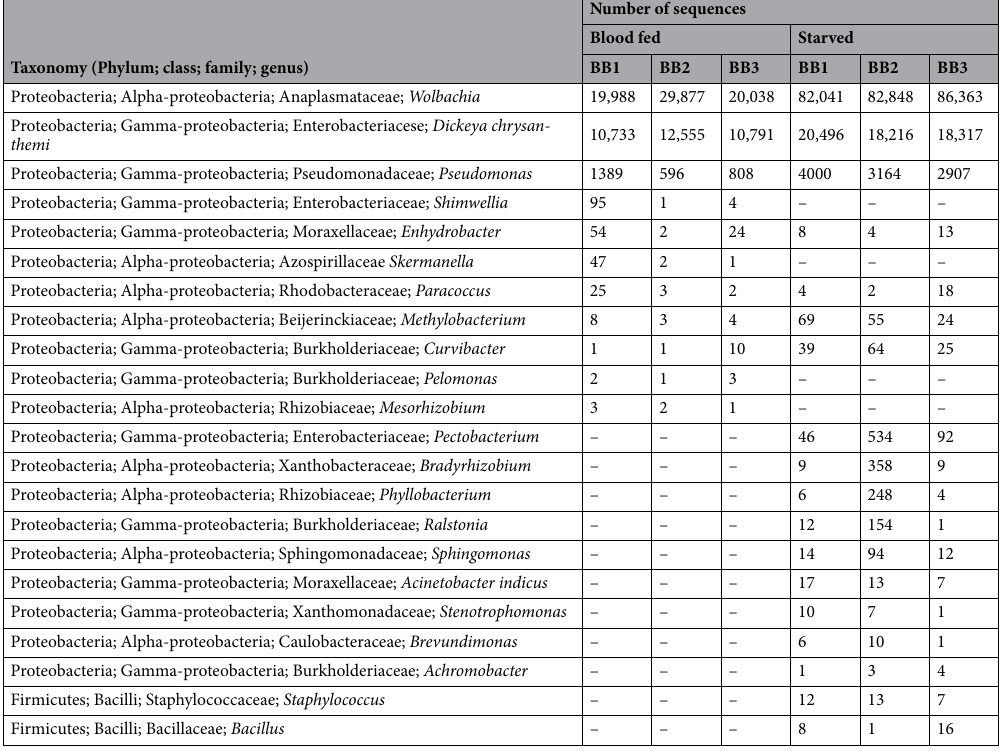
Table 2. Taxonomic classification of bacterial sequences (OTUs) that shared in all three samples either from blood fed or starved bed bugs. “–” indicated not